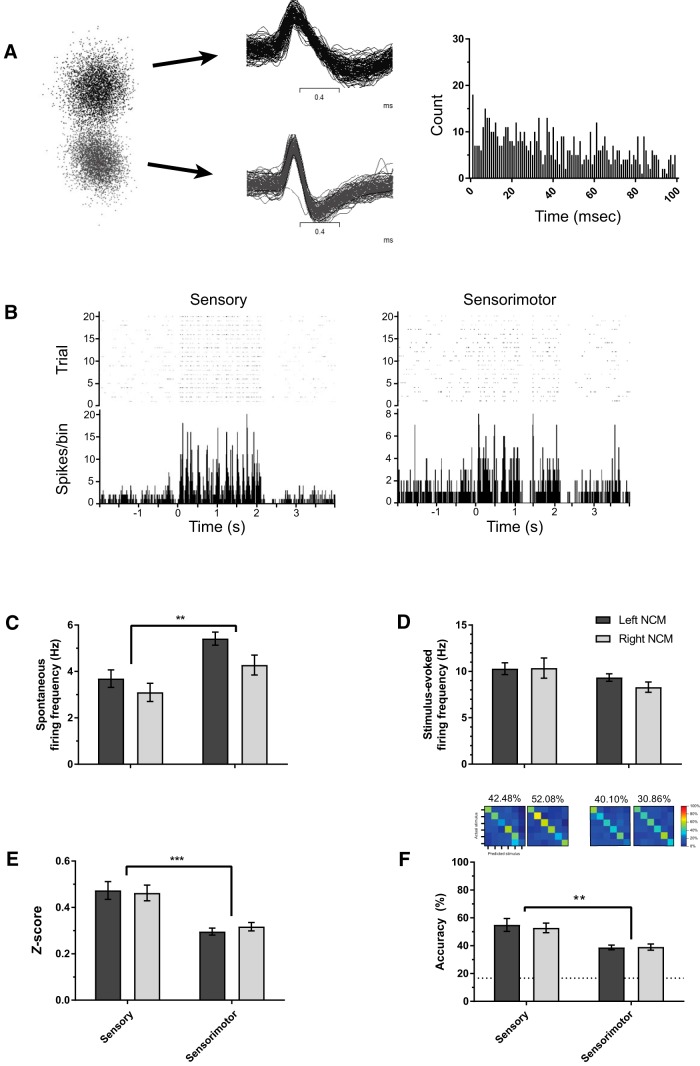
Single-unit auditory response and encoding in NCM is elevated during sensory phase. A, Representative single neurons. Left: Two sorted single units distinctly clustered in principal components space; Middle: 100 sequential iterations from two separate single neurons overlaying their respective wave form template. Right: Interstimulus interval plots for top single unit. Each bin = 1 ms. Units derived from Trial 1 (aCSF) recording from a sensory-aged subject (30 dph; left NCM). B, Raster plot and peristimulus time histogram from representative single units from a sensory-aged and sensorimotor-aged bird (33 [right NCM] and 71 [left NCM] dph). C, D, Spontaneous firing rates are lower in sensory-aged subjects irrespective of hemisphere; however, there are no age-dependent differences in single-unit stimulus-evoked firing rates (D). E, F, Across hemispheres, single-unit auditory z-scores (E) and classification accuracy (F) are significantly higher in sensory-aged birds. Dotted-line in F is chance-level prediction for classifier (1 in 6 chance for accurately classifying a given stimulus = 16.67%). ***p < 0.001; **p < 0.01 (sensory-aged vs. sensorimotor-aged).